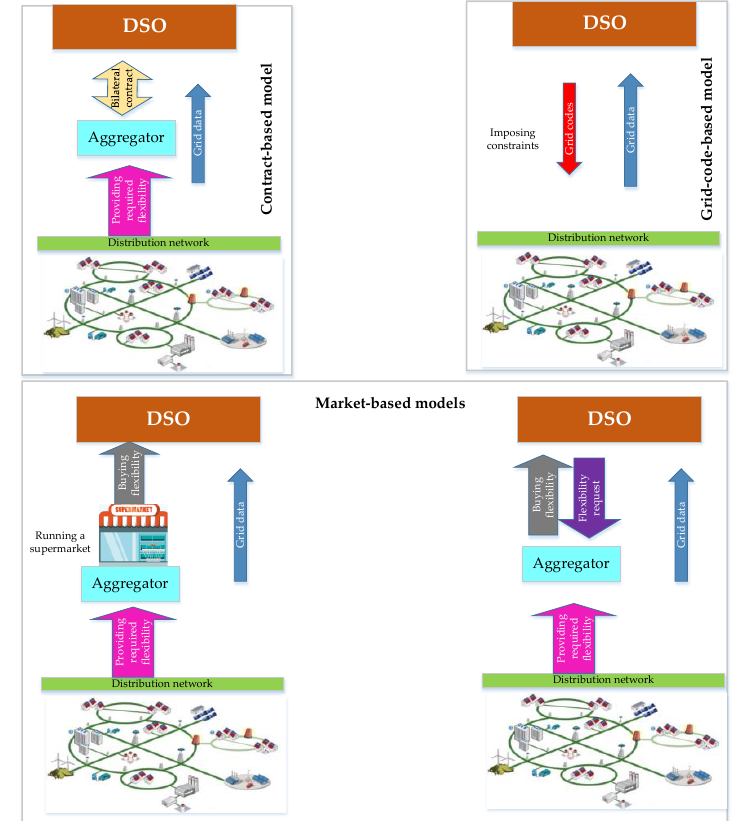
Figure 3. Flexibility trading structure at DSO level.